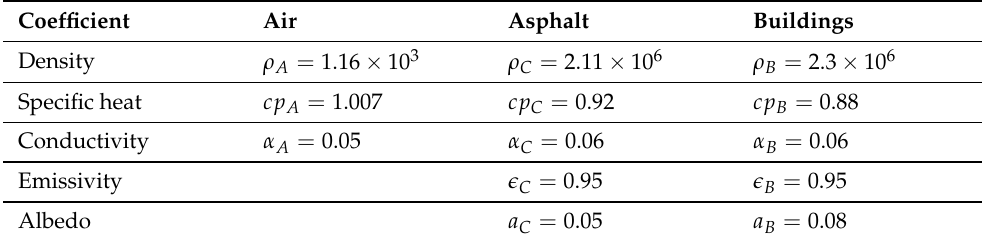
Table 1. Microclimate model